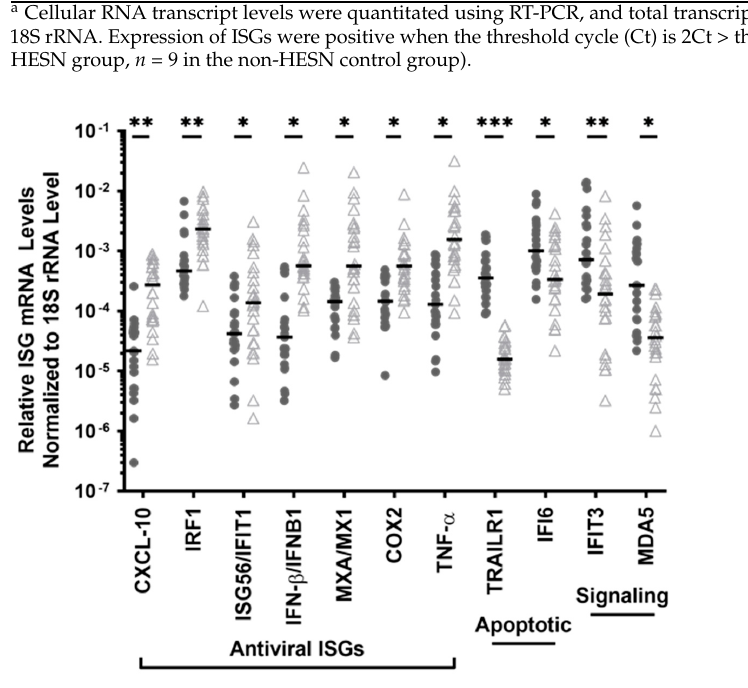
Figure 1. Basal expression of 11 ISGs in the ex vivo PBMC differed between the HESN (•) and the non-HESN controls ( (cid:52) ). Cellular RNA transcript levels were quantitated using RT-PCR, and total transcript levels were normalized to 18S rRNA. Median values ( - ) were shown for each group. Multiple t -tests between the HESN and non-HESN groups were performed (Prism 9.0); n = 23 HESN, and n = 26 non-HESN controls. * p -value <0.05; ** p -value <0.01, *** p -value < 0.001.